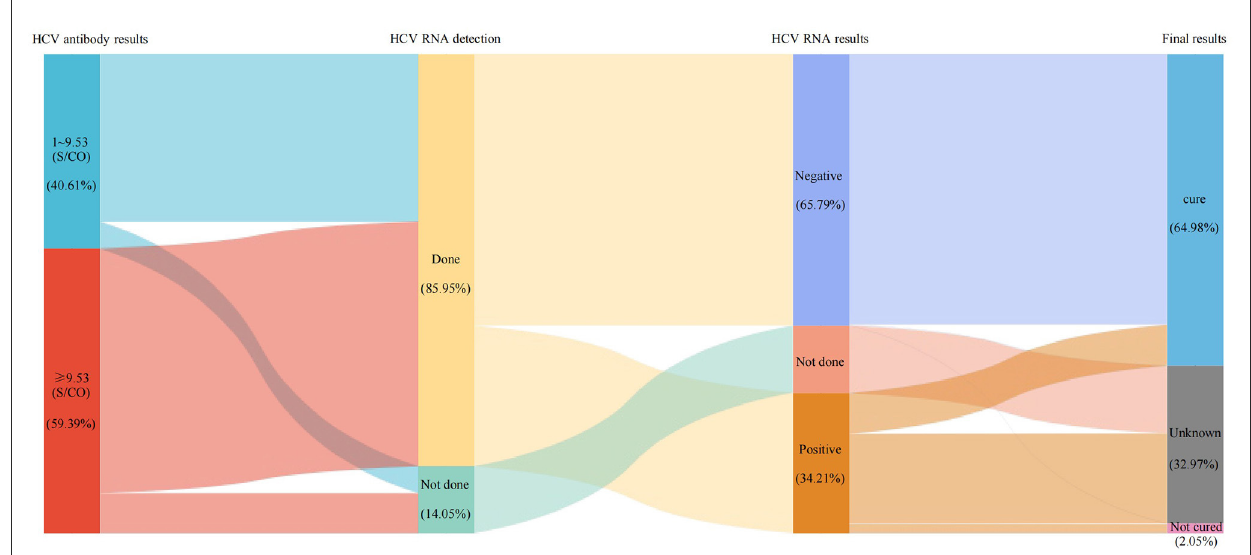
FIGURE4 The care cascade of hepatitis C patient. Each column represents a different subgroup. The area between the columns represents the number and percentage of patients. In the first sub-column, 9.53 S/CO represents the mean value of positive HCV